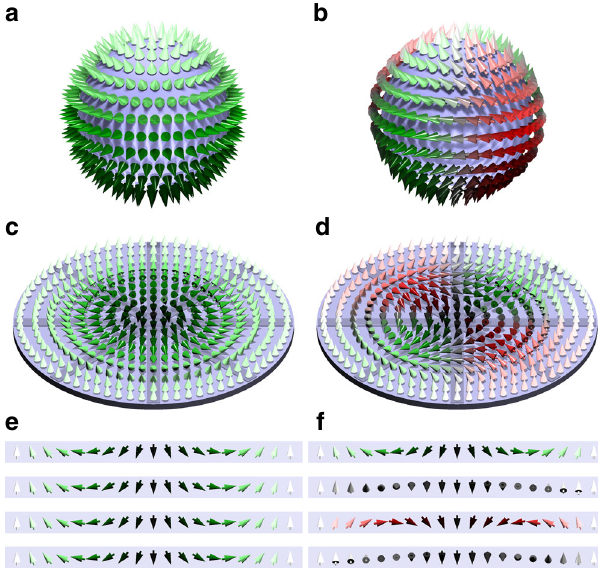
Fig. 1 Comparison of skyrmion and antiskyrmion. a , b Néel-like skyrmion and antiskyrmion schematically shown in c and d mapped onto a sphere. The color code represents the out-of-plane component of the spins via the brightness, with bright ( dark ) spins pointing up ( down ), and their rotational sense in radial direction going from inside out changing from red (clockwise) via gray (vanishing rotational sense) to green (counter-clockwise). e , f Cross sections of the spin textures along the four highlighted directions shown in c and d , see also Supplementary Movie 1 Fig. 2 Relation between symmetry, DM vector and magnetization fi eld.